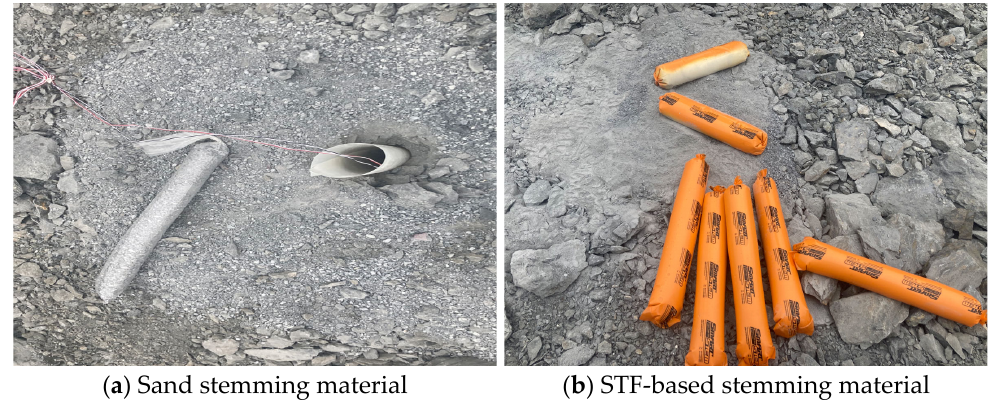
Figure 6. Stemming materials used in blast hole pressure measurement experiment.